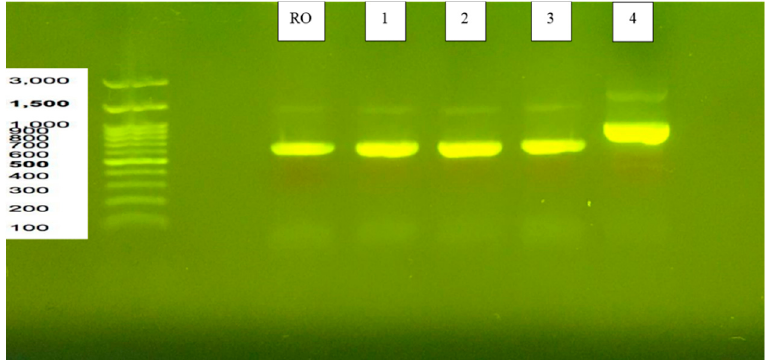
Figure 1. Results of agarose gel electrophoresis analysis for DNA identification of 4 strains isolated from natural tempeh. Strains 1, 2, 3 and 4 had rRNA sequences ranging from 0.5 to 1.0 kb; strains RO, 1, 2 and 3 had the same sequence of around 0.5 kb, while Strain 4 was around 1.0 kb.